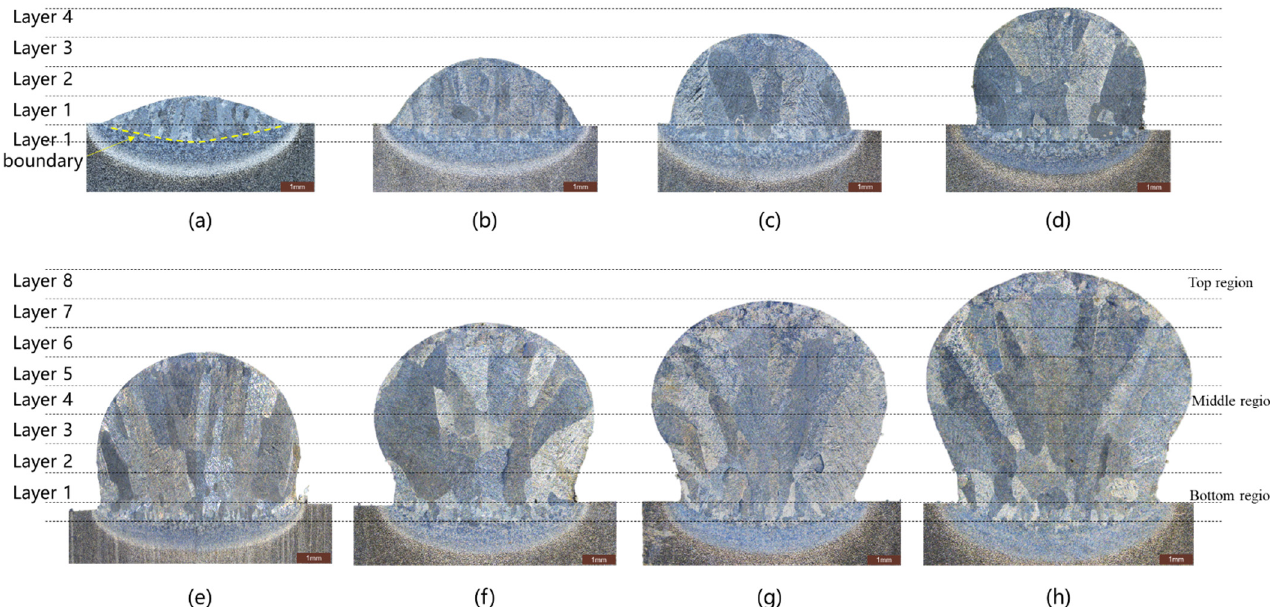
Figure 6. Metallographic observations on the cross-section of each specimen: ( a – h ) represent the solidified structure of each specimen.